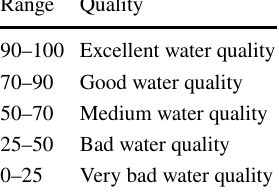
Table 2 Areal extent of landuse types in Osogbo metropolis. Source